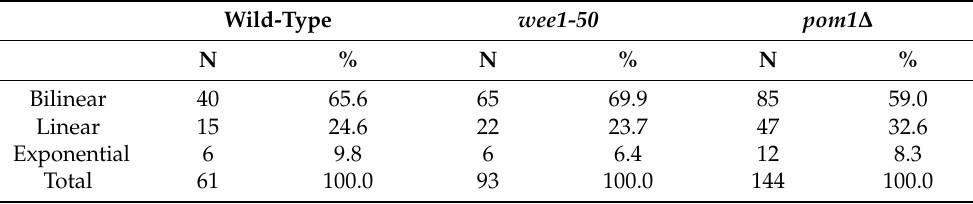
parts of the cell cycle (growth phase I-II, transition period and constant length period) indicated. All the three fitted models (linear, exponential and bilinear) are shown. Table 1. Distribution of different cell length growth patterns in different cell lines based on the AIC model selection criteria.